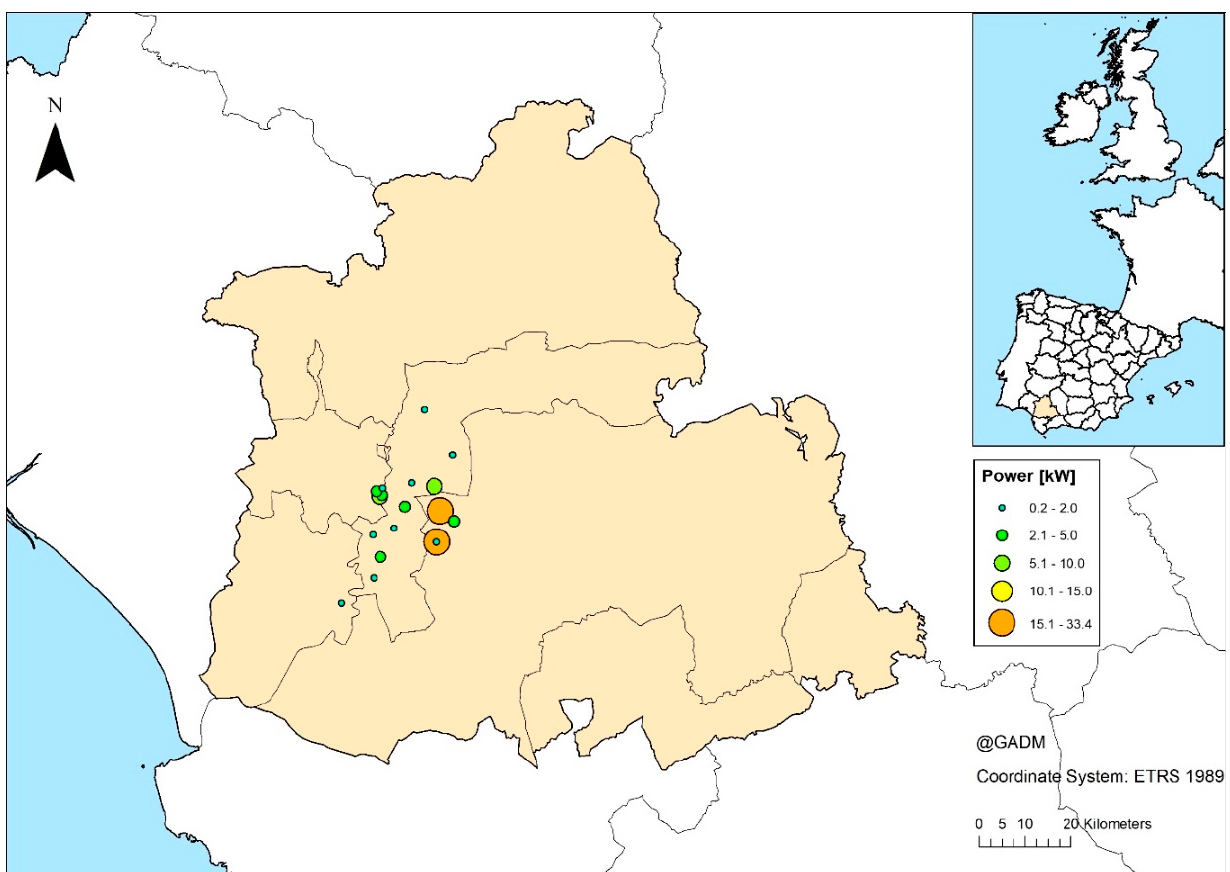
Figure 4. Spatial distribution of MHP energy recovery sites in the drinking water sector in Seville, Spain. Table 2. Potential estimates (>2kW) for MHP by country for drinking water sector and relationship with population served. Country/ Power Pop. Covered Region Estimated (M